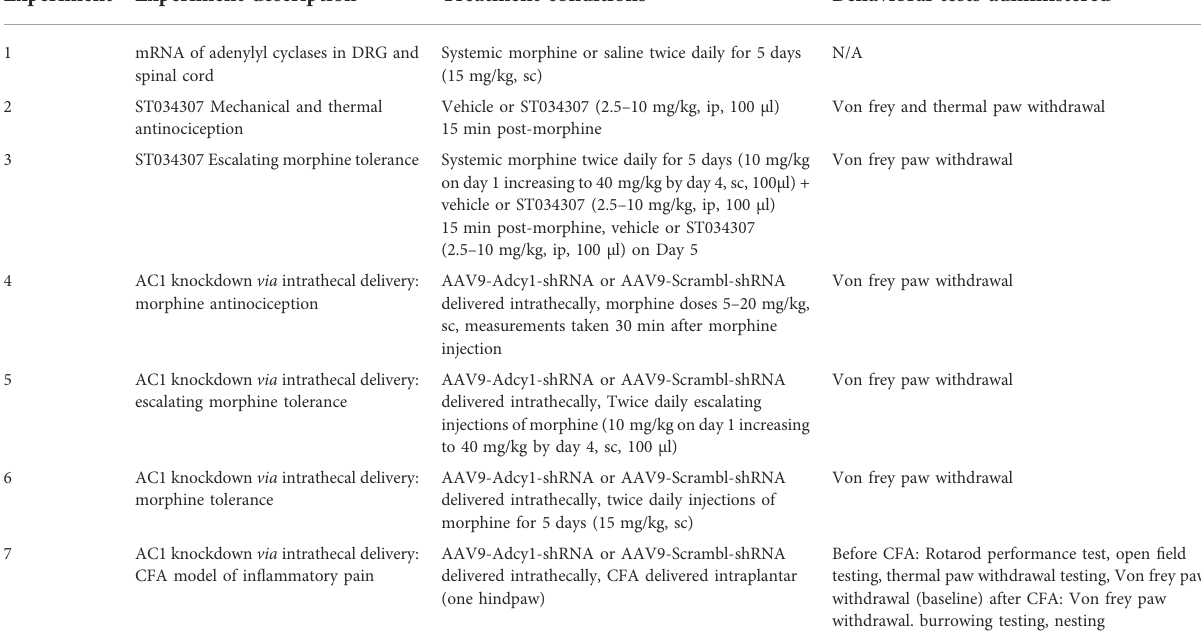
TABLE 1 List of behavioral